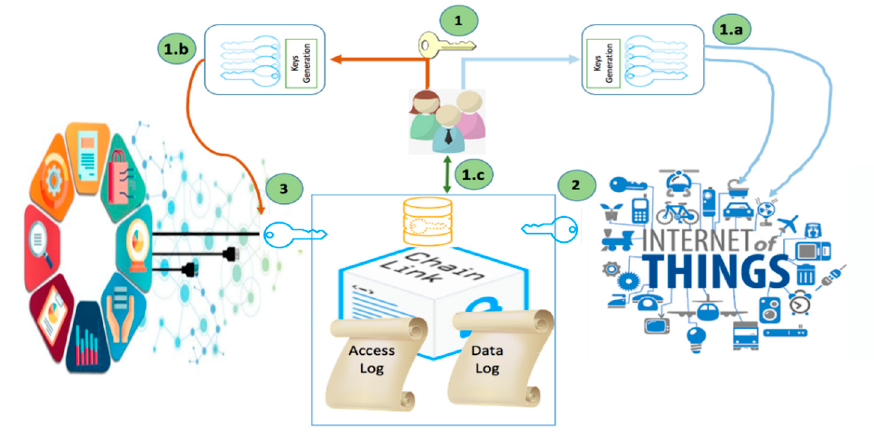
Figure 1. Security management scenario for user data in AmI